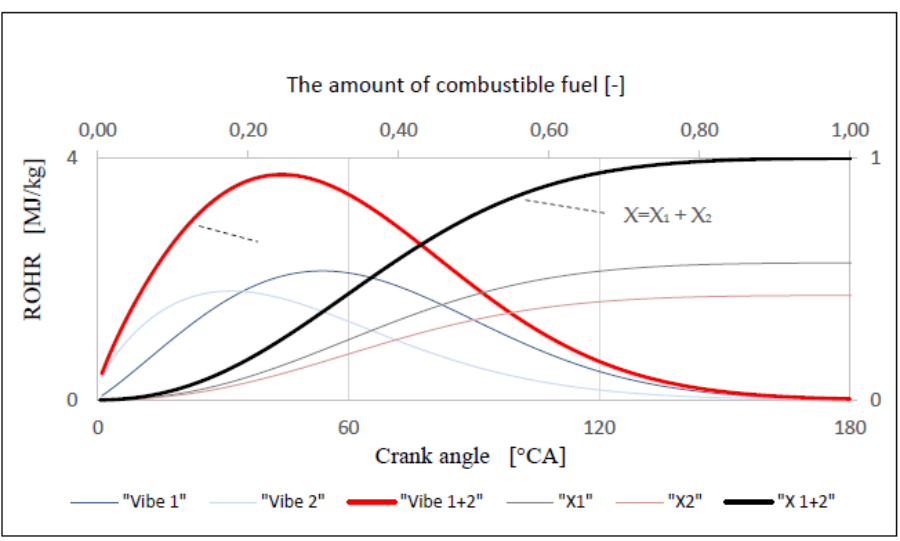
total combustion flow.